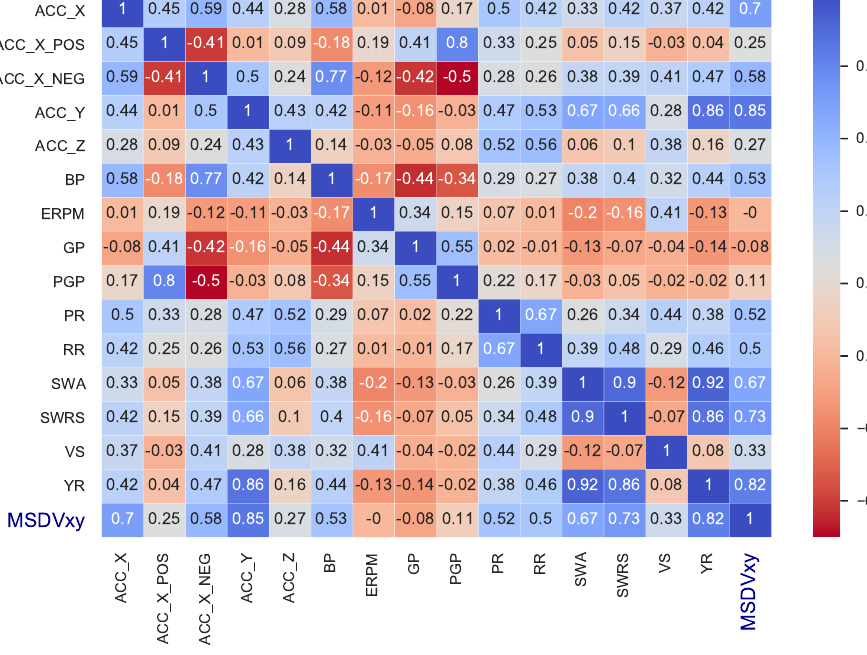
Figure 6. Correlations between all variables that belong to accelerations, rotational speeds, driver − controlled variables, and our discomfort criteria (MSDVxy). Table 1. Different groups of variables after applying feature selection techniques.